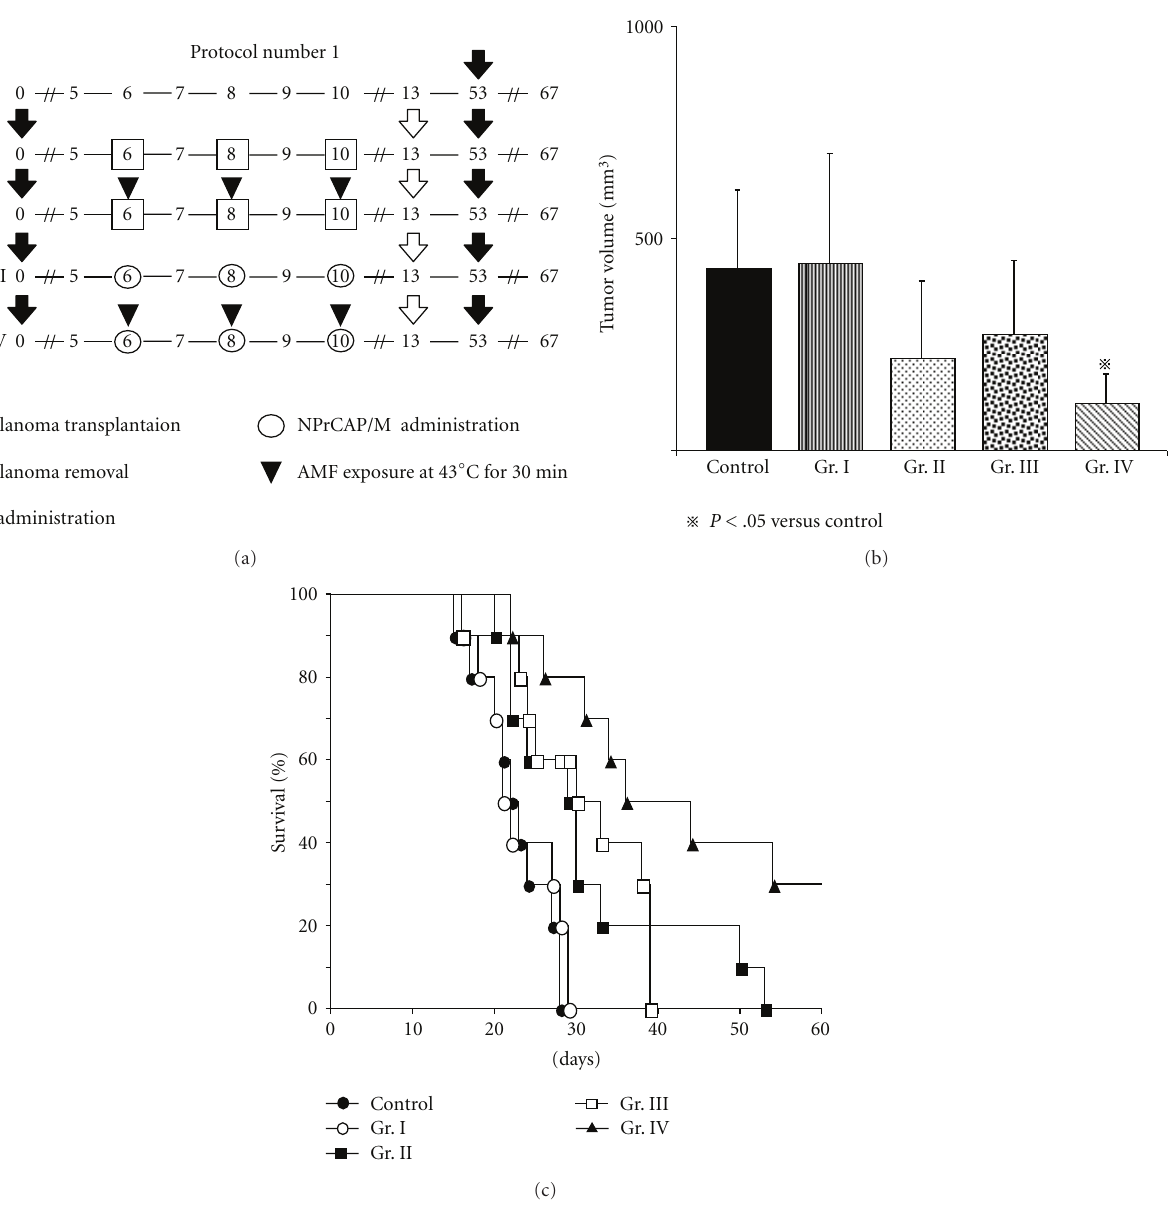
Figure 3: Time schedules and results for tumor volumes, survival periods, and rates of mice treated by the Protocol number 1. (a) Protocols of Groups I, II, III, and IV. (b) Tumor volumes of re-challenge B16F1 melanoma on day 14. All data are presented as mean ± standard deviation. Tumor volumes of Group IV were significantly reduced compared with those of the control group ( P = . 0295) or Group I ( P = . 0215). There were no significant interactions between drugs and AMF ( P = . 5568). (c) Kaplan-Meier survival curve over a period of 60 days after tumor re-challenge in Protocol number